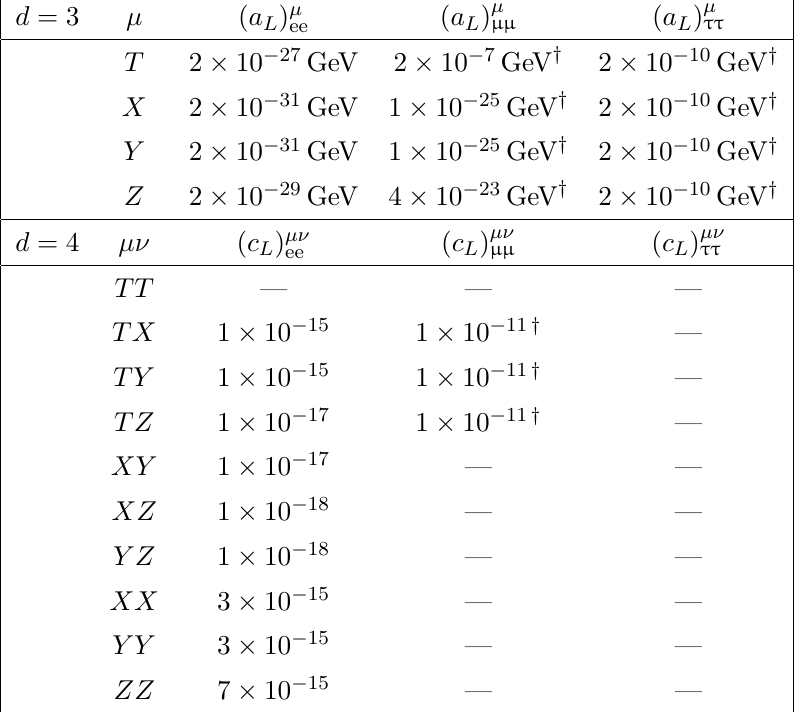
Table 3 . Two-sided potential sensitivities on flavour-diagonal coefficients in the neutrino sector ob- tained from the charged-lepton sector via SU(2) L gauge invariance (see appendix A for calculational details). For the values for ( a L ) µ we assumed that only left-handed fields are modified such AA